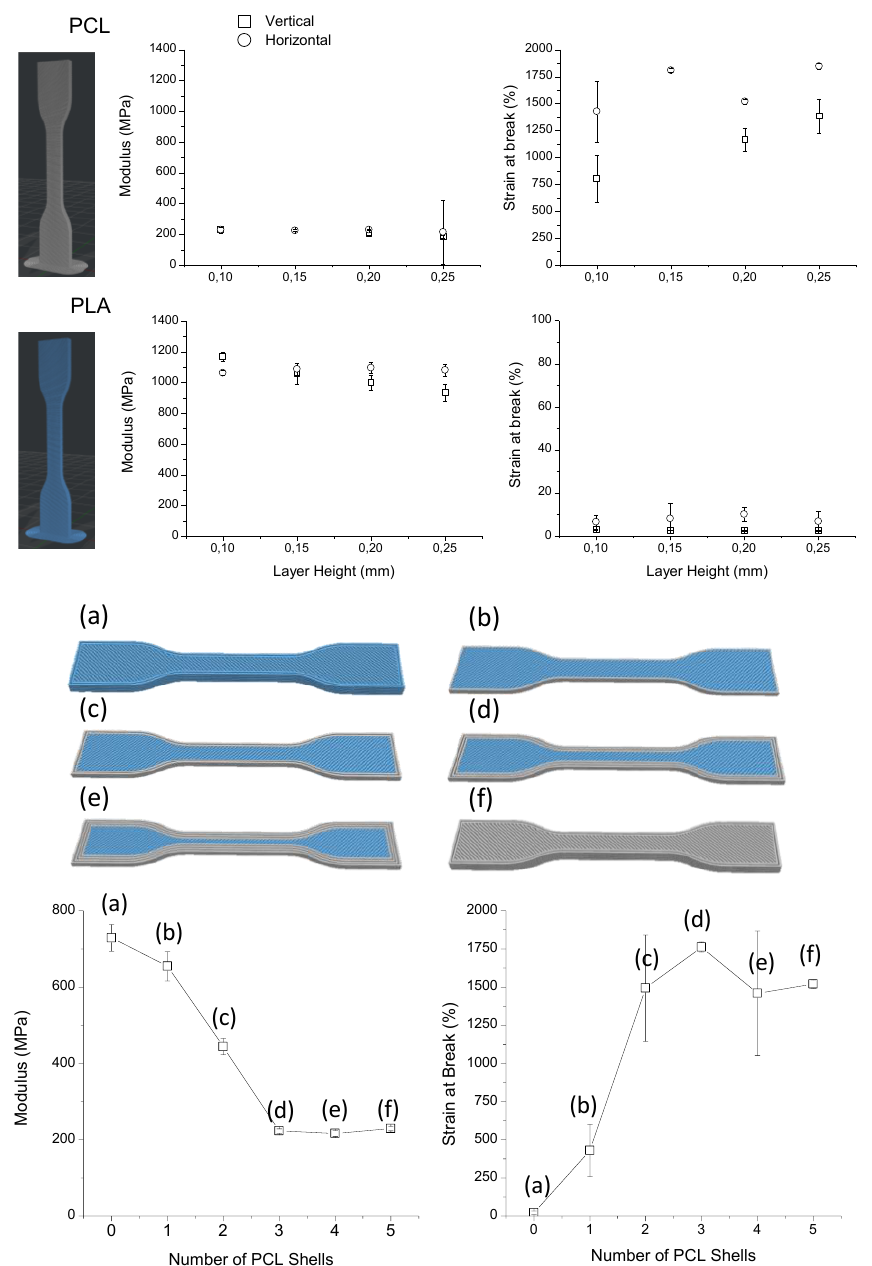
Figure 7. Top: modulus (MPa) and strain at break (%) for PCL. Middle: modulus (MPa) and strain at break of PLA-printed parts. ( a – f ) Illustrative pictures of the horizontally printed specimens with a number of external PLA layers gradually substituted by PCL. Bottom left: modulus (MPa) of the specimens versus de number of PCL shells. Bottom right: strain at break (%). Layer height: 200 μ m.